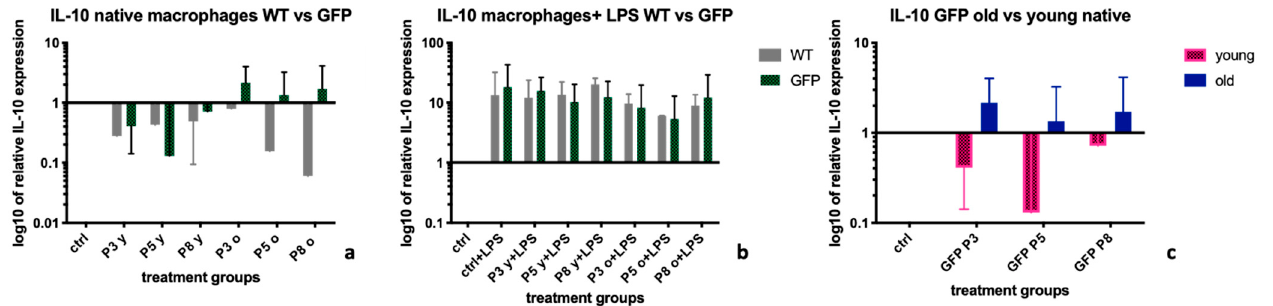
Figure 4. IL-10 expression levels in BMDMs after treatment with MSC-wildtype versus MSC-GFP+ supernatants of different age groups and passages. Figure 4. the graph shows the influence of different MSC supernatants on the expression levels of Interleukin-10 (IL-10 ) on BMDMs extracted from a WKY-WT rat . Supernatants from MSCs from GFP+ donor rats led to a higher upregulation of IL-10 expression levels in native BMDMs than supernatants from WT-MSCs ( a ). Particularly supernatants from older GFP+ rats led to an increase of IL-10 expression levels ( b ). In untreated BMDMs, results indicated a more potent up-regulation of IL-10 after treatment with supernatants from old MSC donors in comparison to their young equivalents ( c ). mRNA levels were calculated using RT-PCR and the ΔΔ Ct-method. Untreated macrophages served as control and HPRT-1 was the housekeeping gene. Statistical significance: no statistical significance (ns; no asterisk); BMDM = bone marrow derived macrophages, IL-10 = Interleukin-10 , WT = supernatants coming from wild-type cells, GFP = supernatants from GFP+ cells. Old = supernatants from cells from donor rats > 6 months of age, young = supernatants from cells from donor rats < 6 months of age.